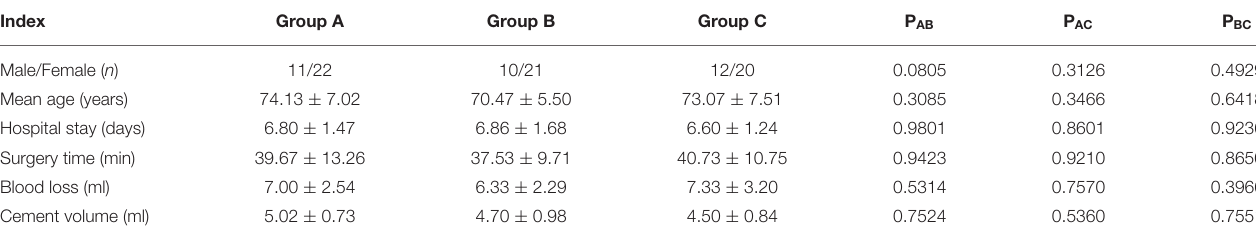
TABLE 1 | Characteristics and clinical findings.